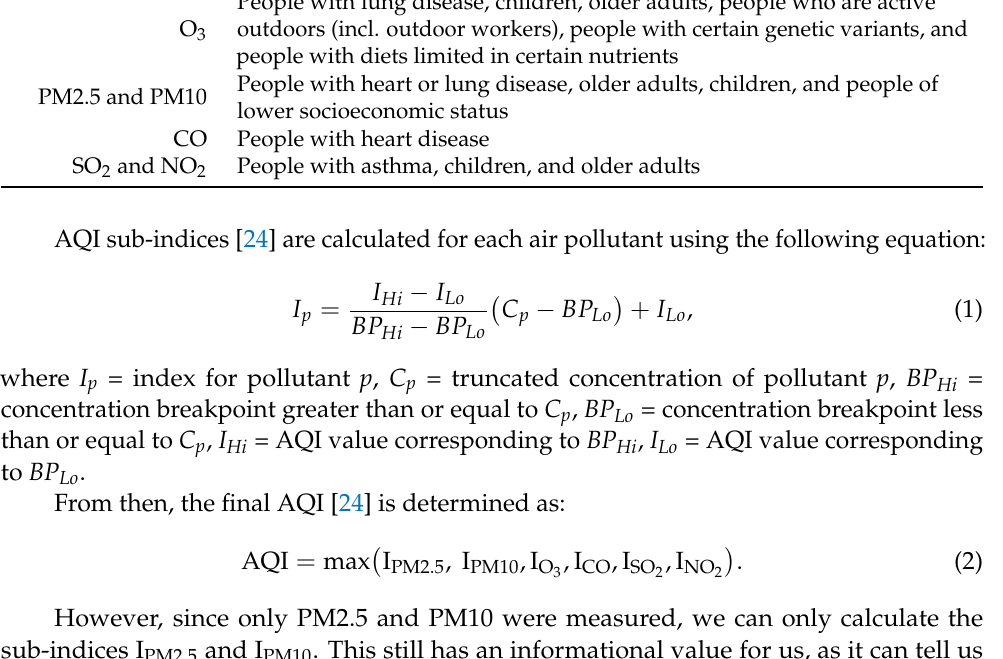
201–300 Very unhealthy